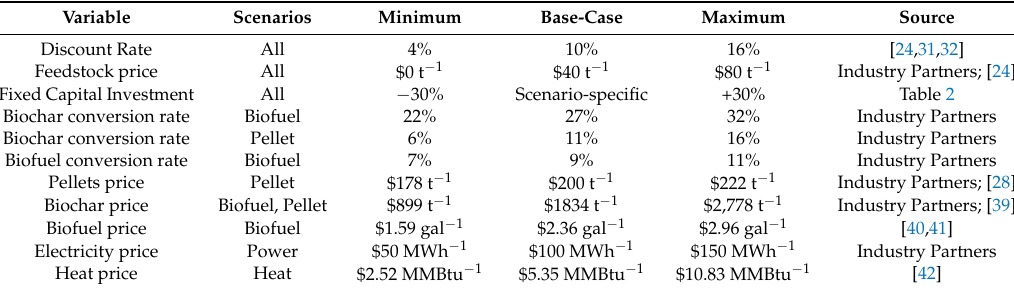
Table 3. Summary of uncertain inputs.